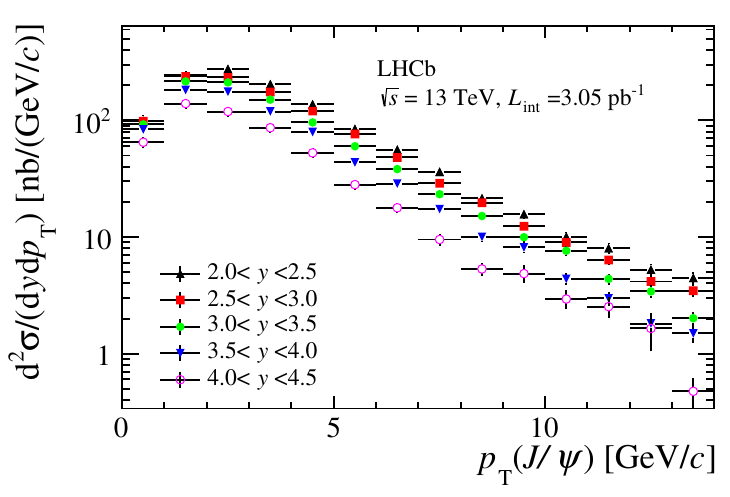
Figure 3 . Double di(cid:11)erential cross-section for J= -from- b mesons as a function of p T in bins of y . Statistical and systematic uncertainties are added in quadrature.